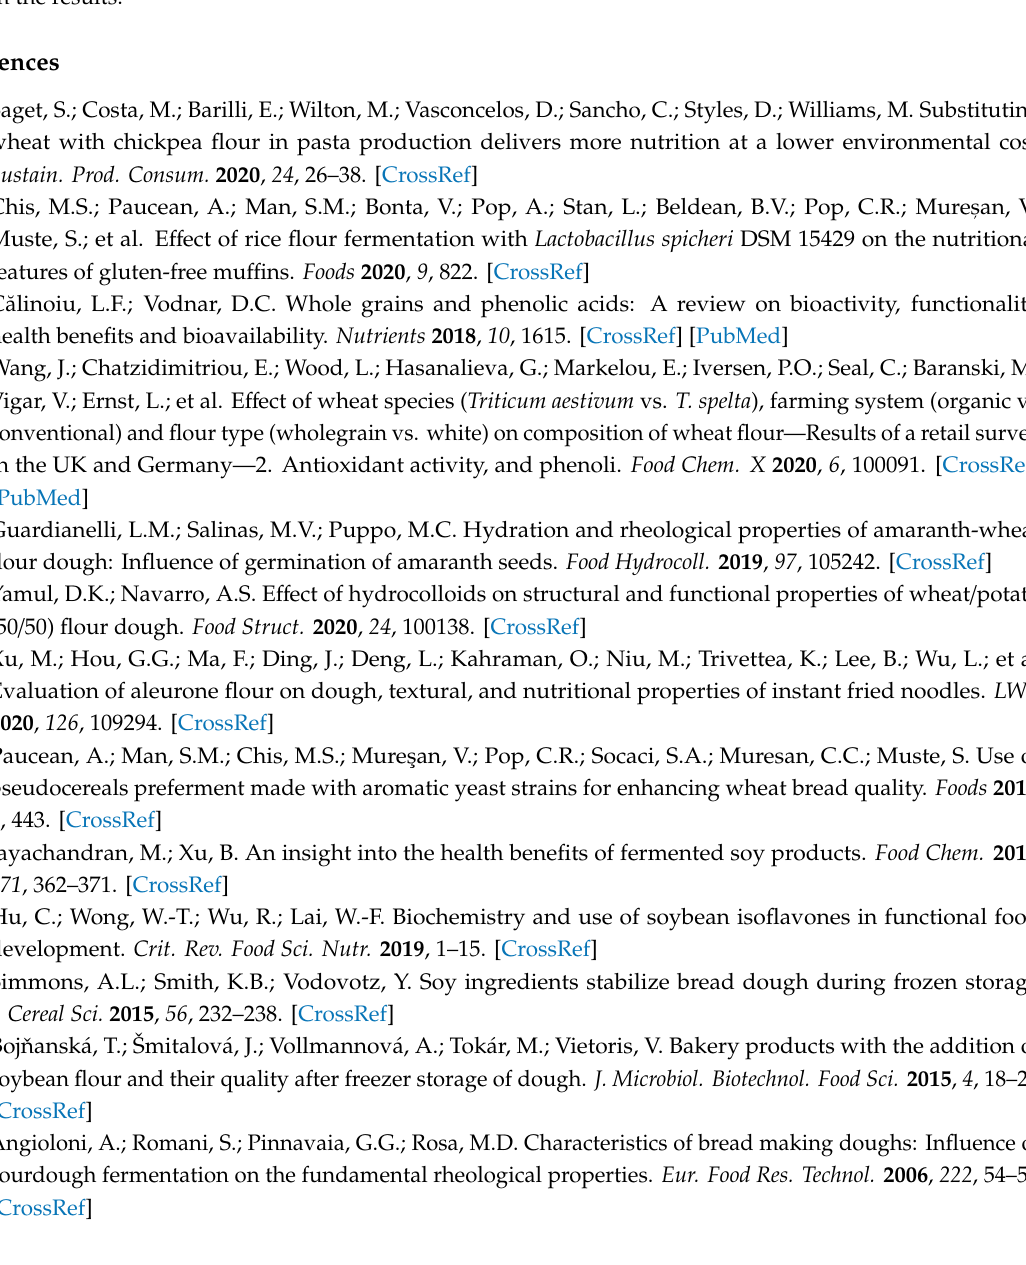
Figure S1. HPLC chromatogram of organic acid standards and retention times; Table S1. Cell viability and pH profile of the fermentations at the three di ff erent substrate concentrations (wheat and soy-flour) and MM for 24 h with the cocultures; Table S2. The standard deviation of storage (G (cid:48) ) and loss (G (cid:48)(cid:48) ) shear moduli for 100% wheat flour with LP + LC cocultures; Table S3. The standard deviation of storage (G (cid:48) ) and loss (G (cid:48)(cid:48) ) shear moduli for 95% wheat flour and 5% soy flour with LP + LC cocultures; Table S4. The standard deviation of storage (G (cid:48) ) and loss (G (cid:48)(cid:48) ) shear moduli for 90% wheat flour and 10% soy flour with LP + LC